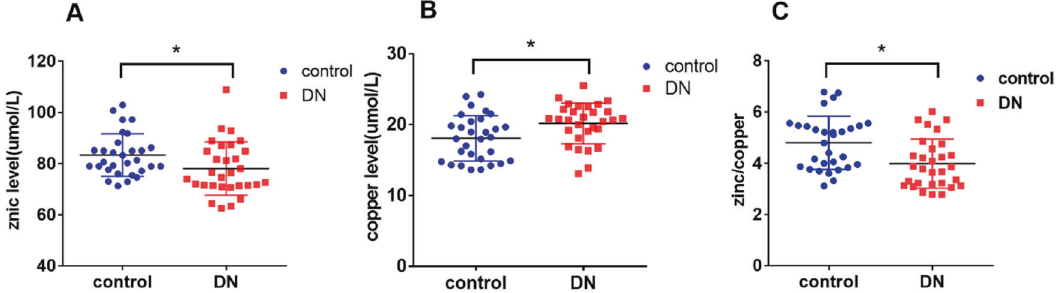
Fig. 1 Scatter diagrams showing the plasma levels of zinc, copper, and zinc/copper. A Plasma zinc levels were signi fi cantly decreased in the DN group compared to those in the control group (* P < 0.05). B Plasma copper levels were signi fi cantly increased in the DN group compared to those in the control group (* P < 0.05). C The ratio of zinc and copper was signi fi cantly decreased in the DN group compared to that in the control group (* P <